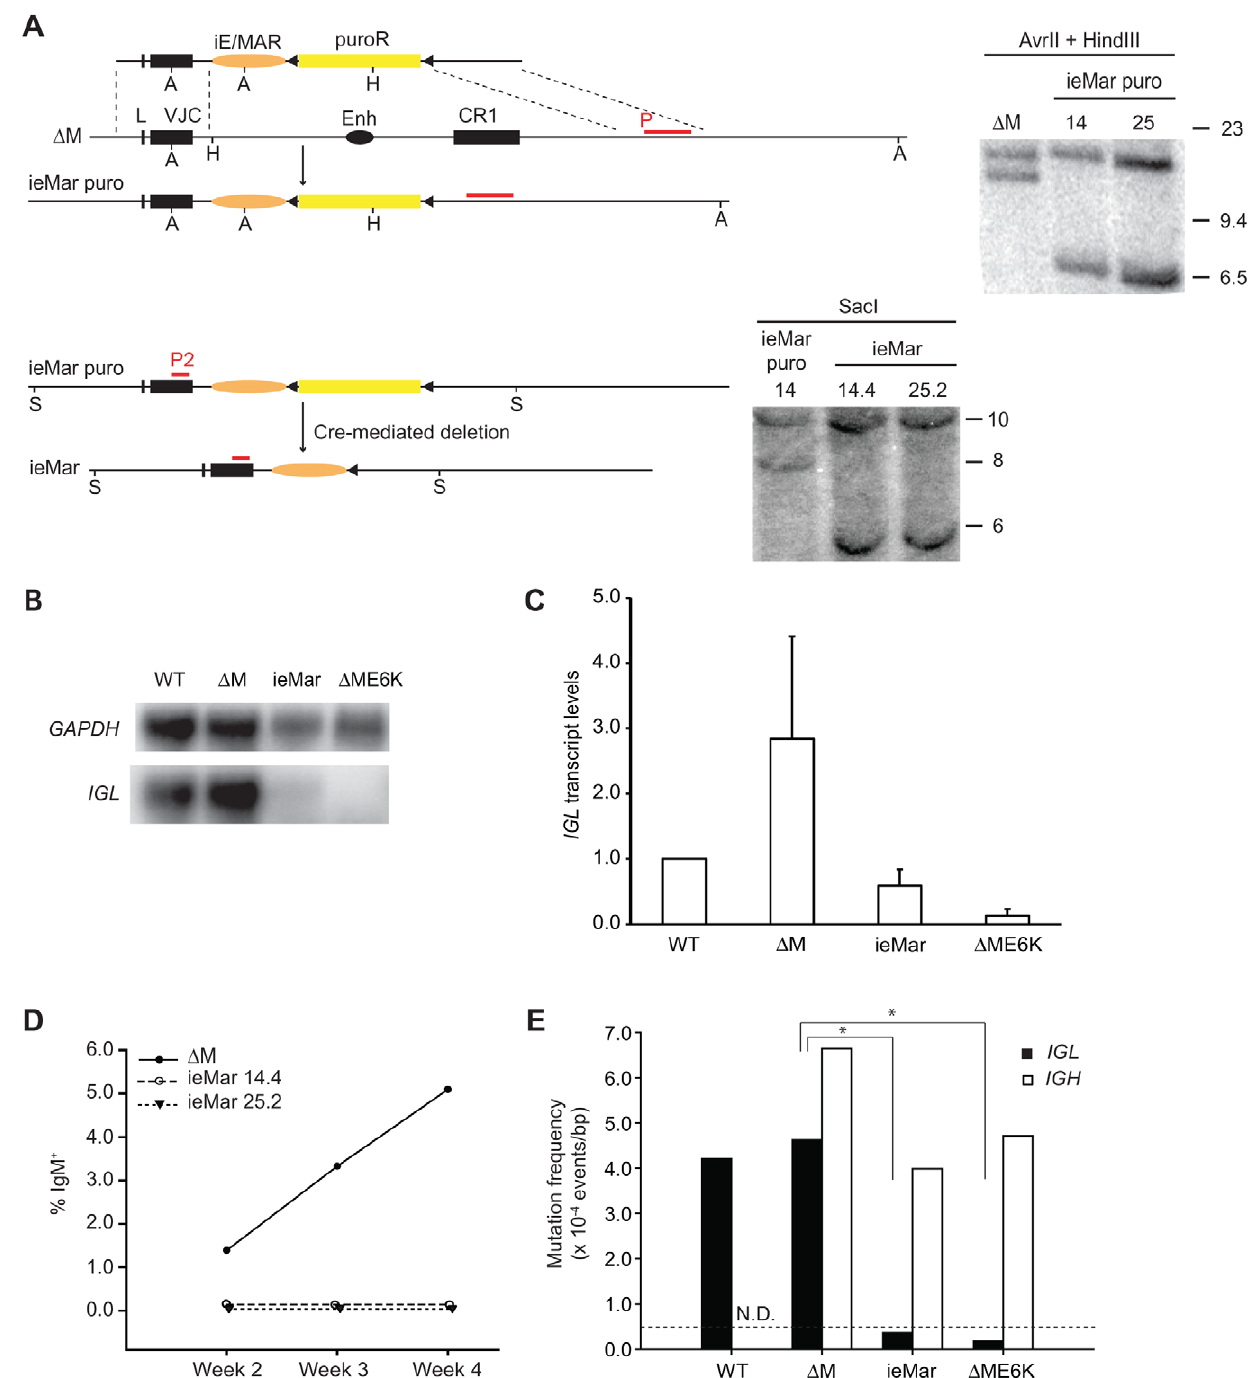
Figure 2. Functional analysis of the iE/MAR enhancer element. A) Schematic representation of the gene-targeting approach. The rearranged IGL allele of the parental D M line, the intermediate ieMAR puro allele, and the final product, the IGL locus of the ieMar DT40 cells, are drawn to scale. The targeting vector is shown with its homology arms, the iE/MAR (orange oval), the puromycin selection cassette (yellow box) and flanking loxP sites (filled triangles), but the plasmid backbone is omitted for clarity. The restriction sites used for the Southern blot analyses are marked (A: AvrII, H: HindIII, and S: SacI), and the probes for each step (P1 and P2, respectively) are shown as red lines above the locus. The asterisk in each Southern blot marks the band that originates from the non-rearranged allele. B) Northern Blots were run using 10 m g of total RNA of wild-type (WT) DT40 cells and each of the indicated cell lines, and hybridized sequentially with IGL and GAPDH probes. One representative example is shown. C) Steady-state transcript levels of IGL were measured by Northern blot and normalized to those of GAPDH. The level in wild-type (WT) cells was arbitrarily set to one, and each data point represents the average of at least four independent values per genotype. D) GCV was assessed by flow cytometry over four weeks starting from single cell clones. The average percentage of IgM + cells in a total of 24 subclones from two independent ieMar lines is shown at